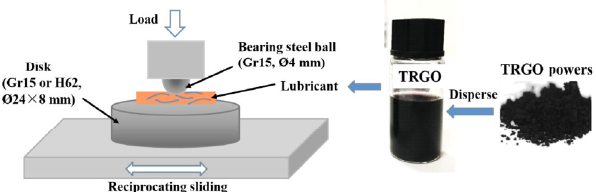
Fig. 1 Configuration of a ball-on-disk experimental setup for reciprocating sliding conditions.